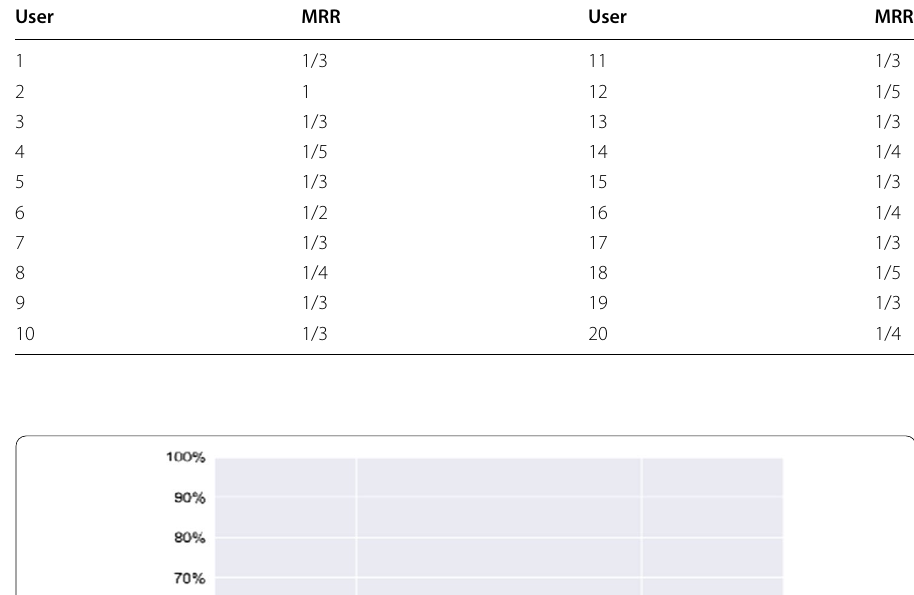
Table 13 MRR based on A(P) and F(P) review category